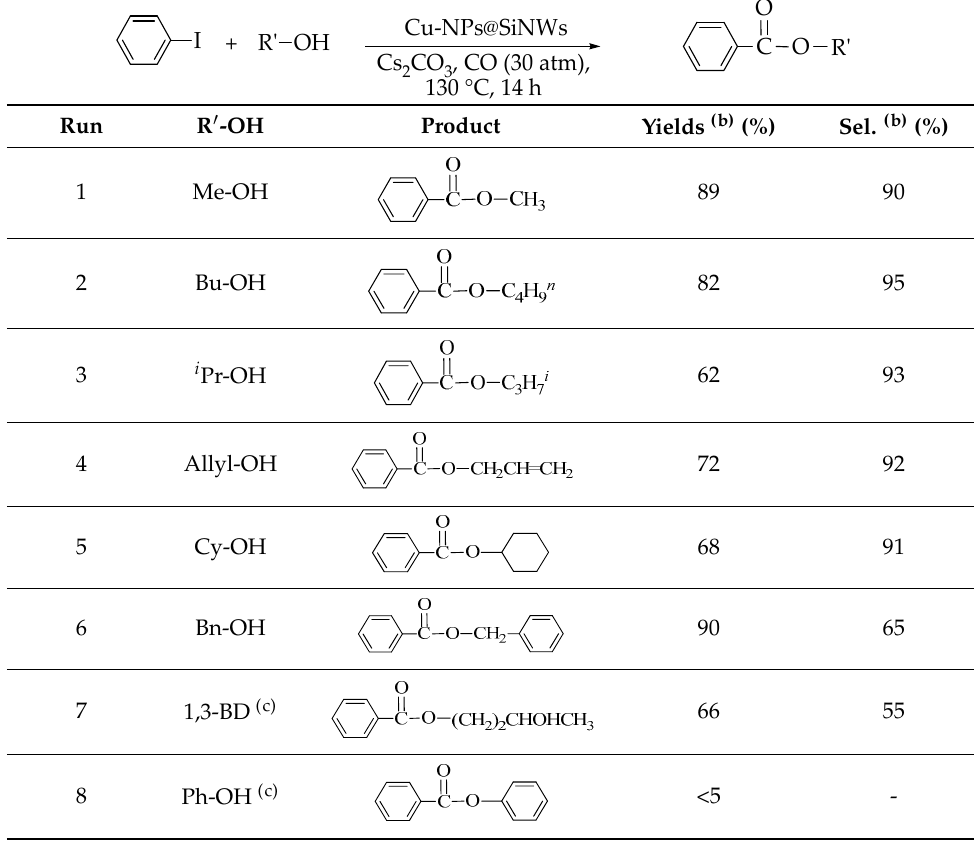
Table 3. Alkoxycarbonylation of iodobenzene catalyzed by CuNP@SiNWs (a) .